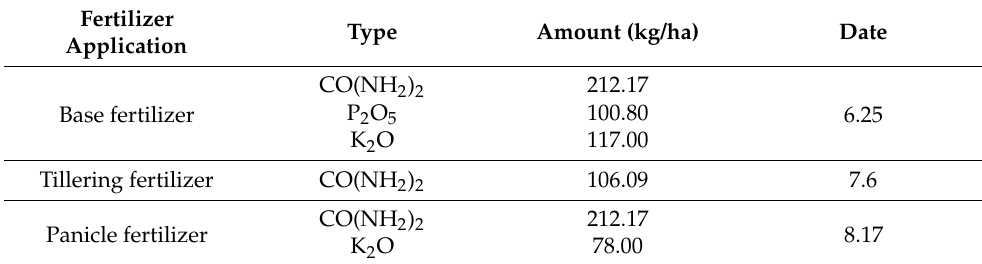
Table 1. Fertilizer Application.